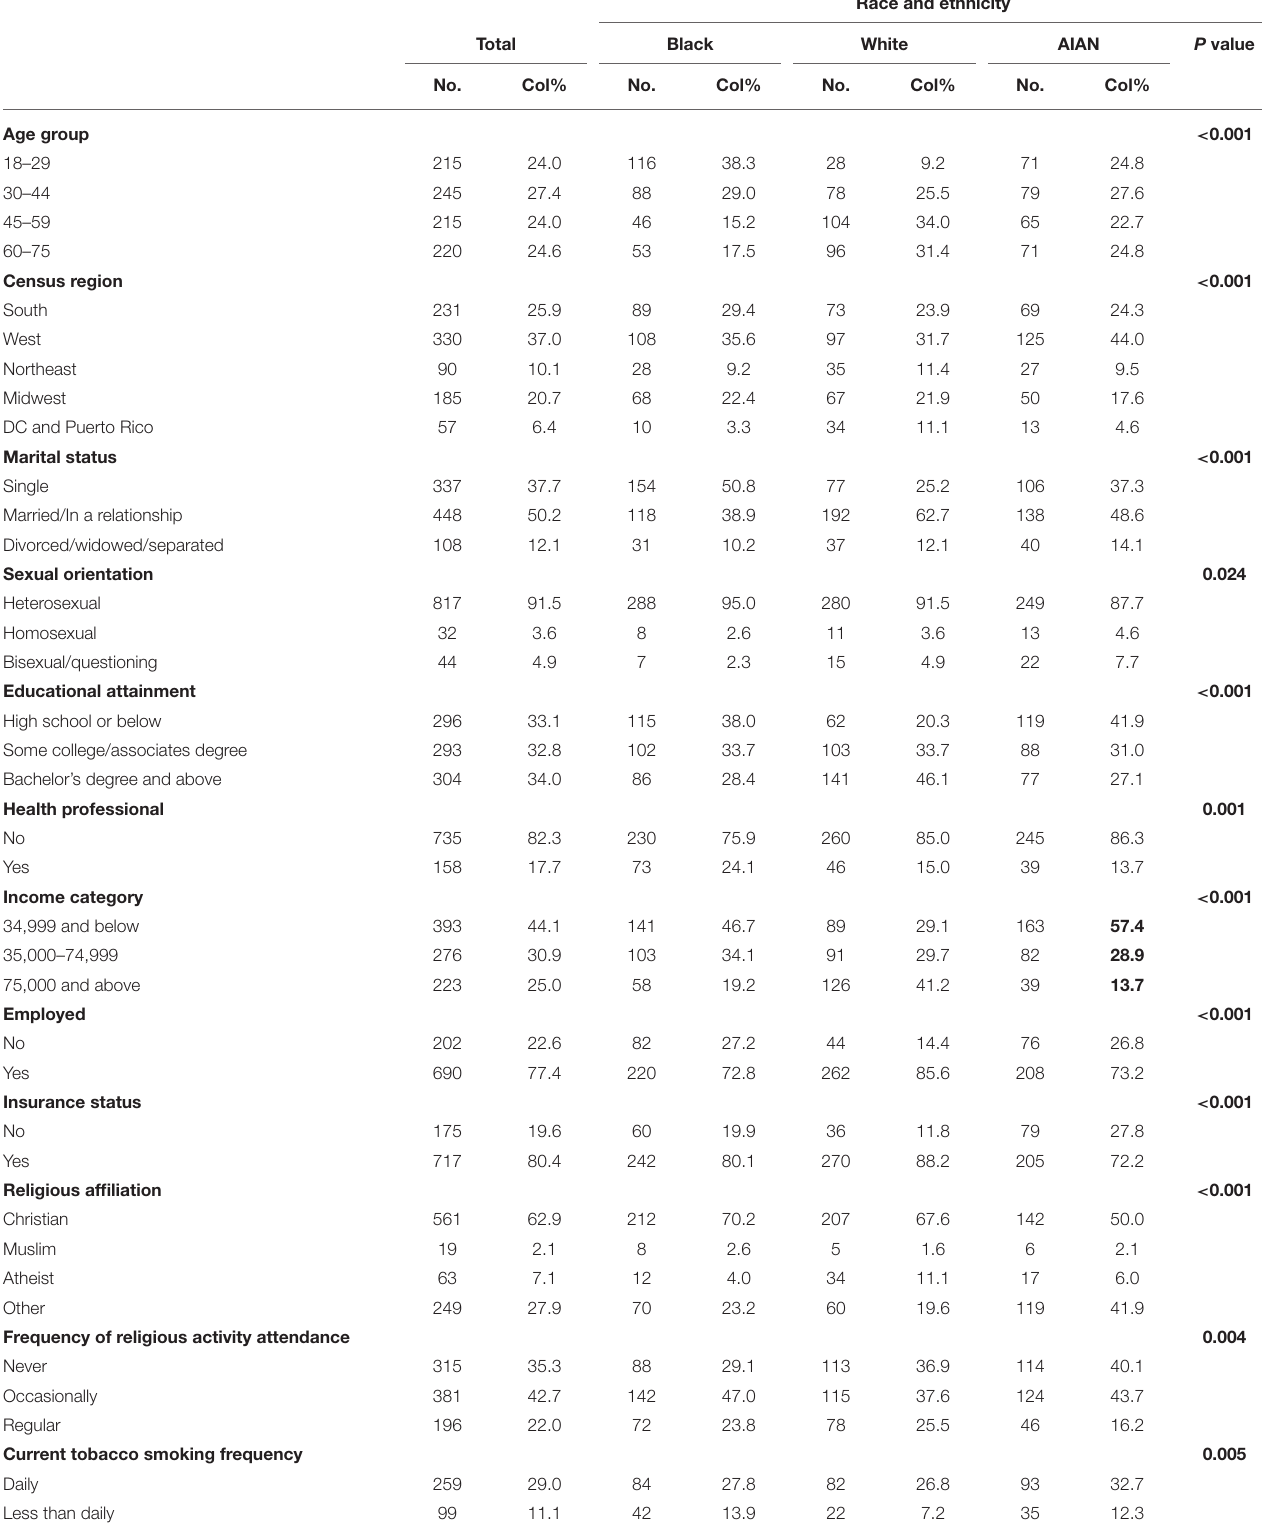
TABLE 1 | Sociodemographic characteristics of 895 diverse men to evaluate masculinity barriers and intention to screen for CRC (November 2020 to January 2021).